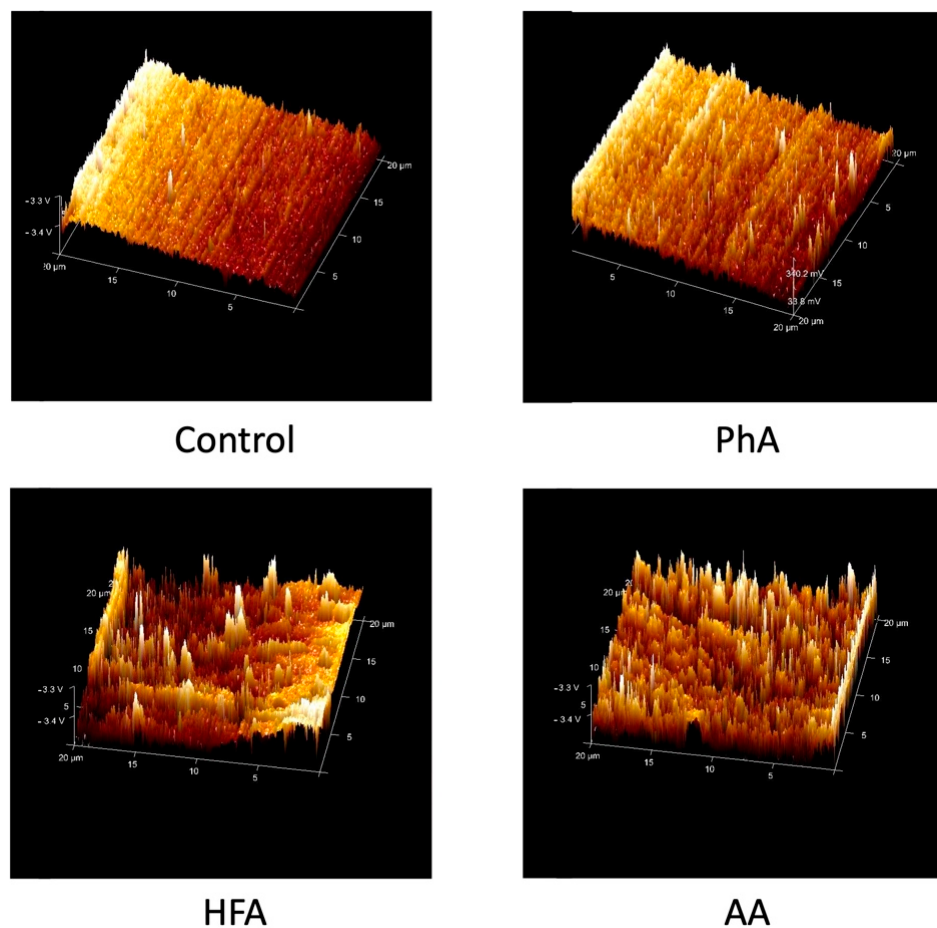
6 of 13 Figure 3. Ceramic surface roughness results. Values with different superscript letters indicate sig- nificant differences ( p < 0.05) (a > b > c > d). Representative AFM images of the ceramic surfaces treated with different condition-